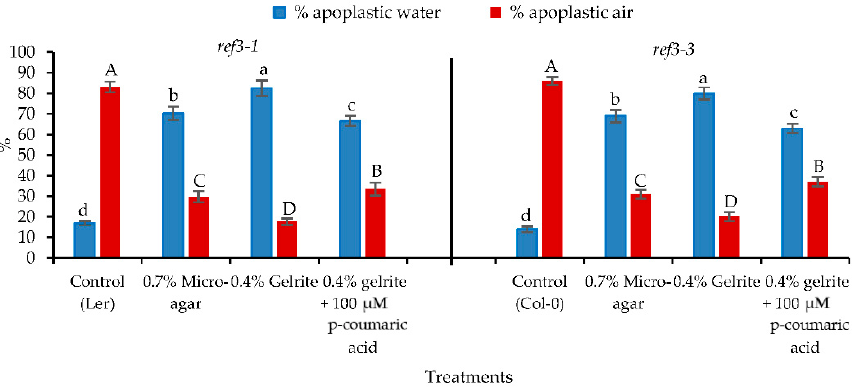
Figure 5. The percentages of apoplastic water and air related to the total volume of the apoplast in Arabidopsis thaliana less-lignin-mutant ref3-1 and ref3-3 seedlings after 14 days of culture on 0.7% ( w / v ) Micro-agar, 0.4% ( w / v ) gelrite and 0.4% gelrite ( w / v ) + 100 µ M p -coumaric acid. Different letters indicate significant differences between means at α = 0.05 level.